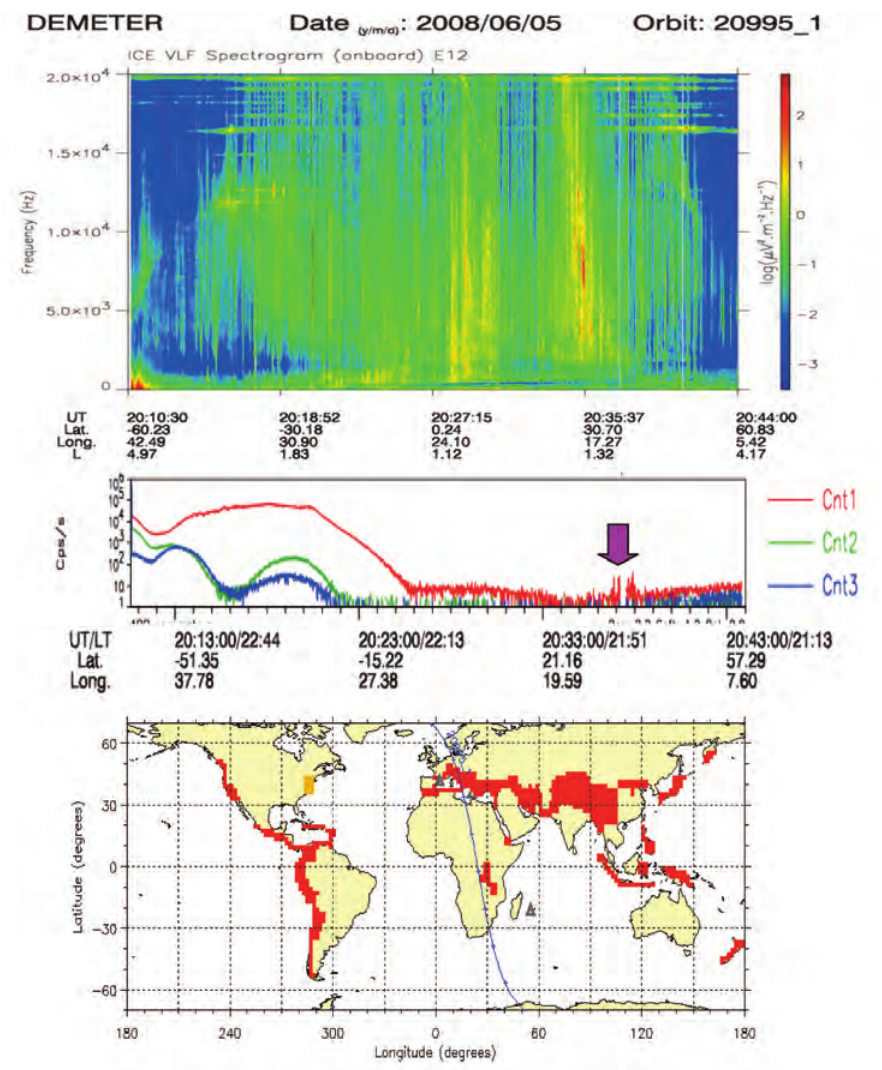
Figure 3. Observations from the DEMETER satellite on June 5, 2008, about three days before the occurrence of an earthquake in Andravida, Greece. The electron enhanced activity recorded at a geographic latitude (37.93˚N) similar to that of August 16, 2005, earthquake in Japan (38.3˚N), although instead of one peak superimposed on the (high) flux background in Japan, a sequence of electron peaks are evident here (b) under a very low background flux level. The EB is well related in time to the presence of a broadband (~2-19 kHz) VLF activity